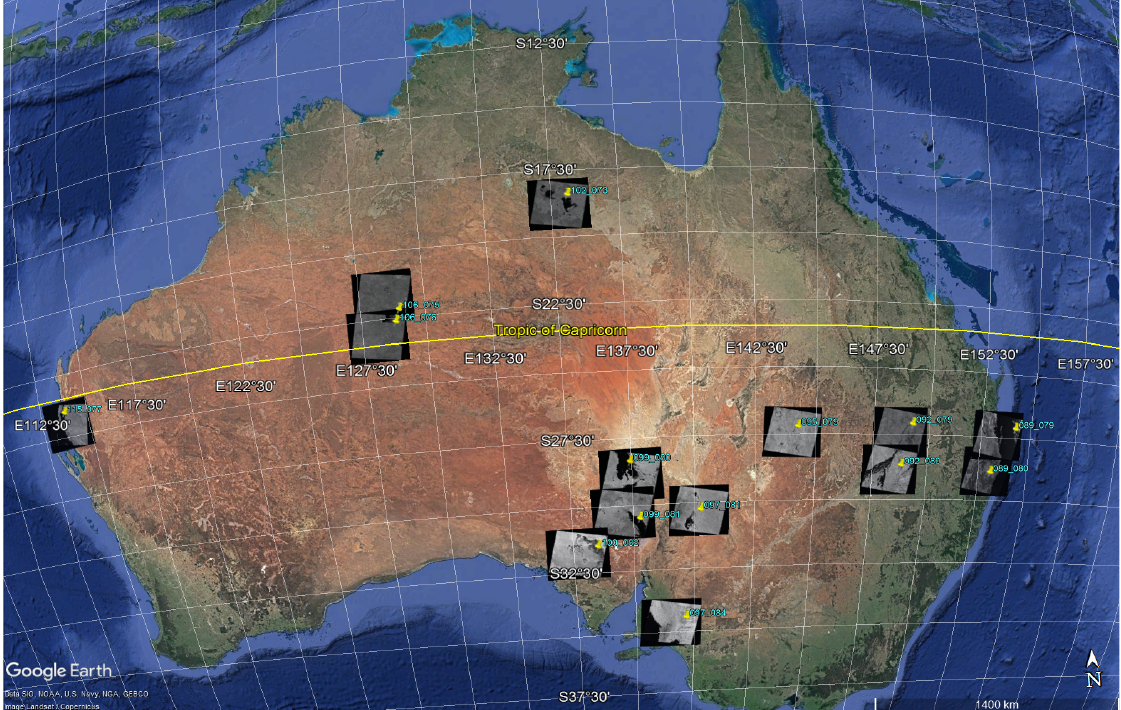
Figure 2. Footprints of the selected Landsat-5 TM images: A single band (Band-5) of each selected Landsat-5 images is overlaid on the Google Earth map based on their